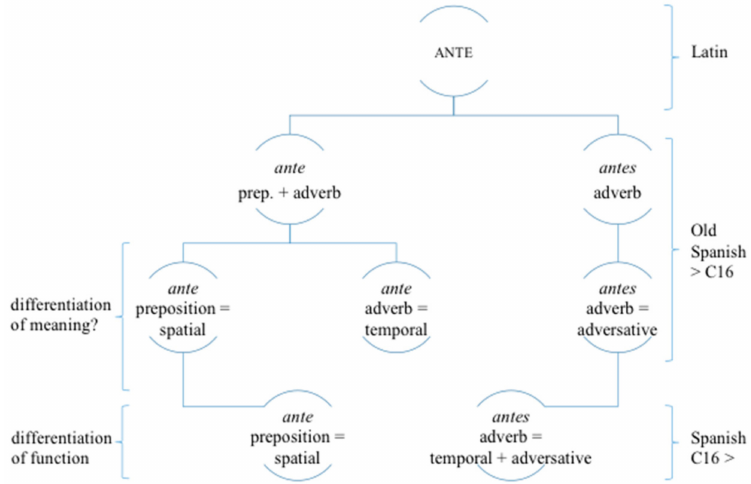
Figure 1. Different functions and meanings of ante and antes in diachronic